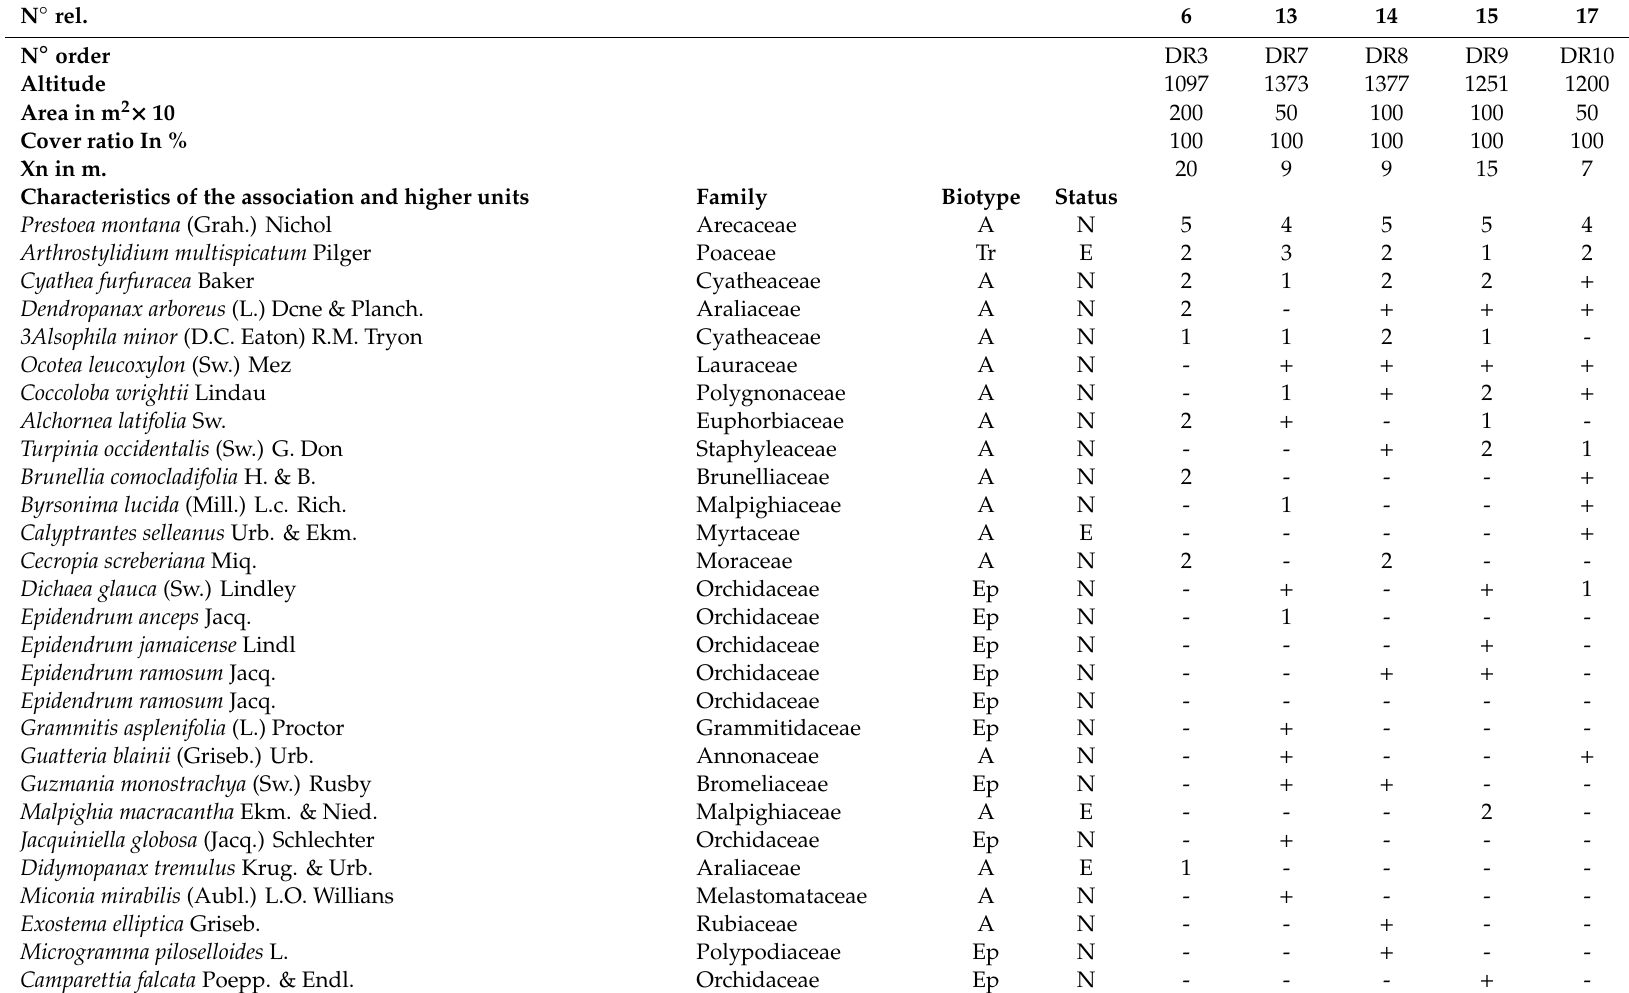
Table A2. Association Cyatheo furfuracei-Prestoetum motanae.